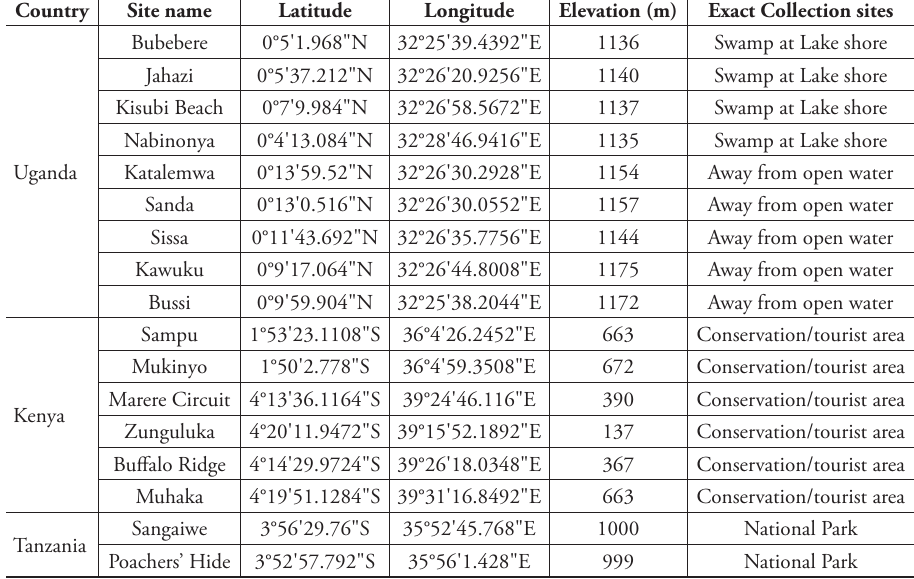
Table 1. Fly collection sites and their respective GPS